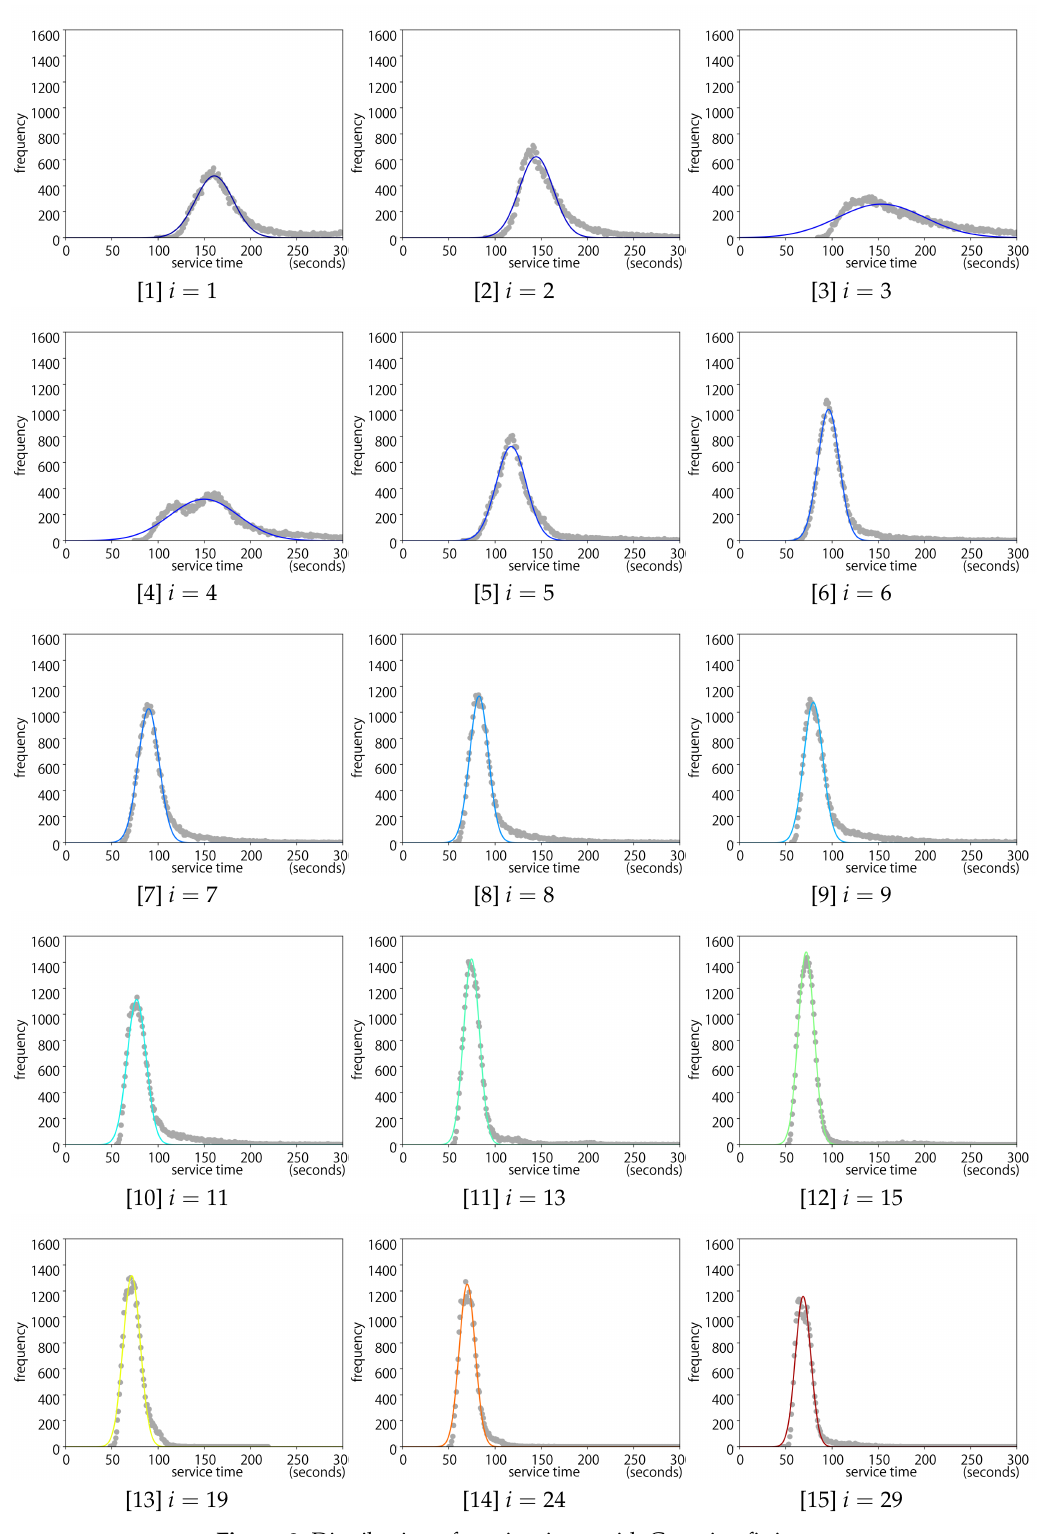
Figure 8. Distribution of service times with Gaussian